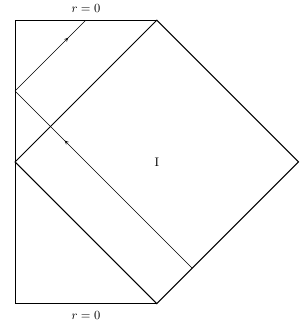
Figure 9. Representation of the Schwarzschild spacetime by half of the Kruskal-Szekeres spacetime. The solid line with arrows represents a light beam propagating into the black hole. For realistic black holes, the white hole and its event horizon need to be replaced by the collapsing